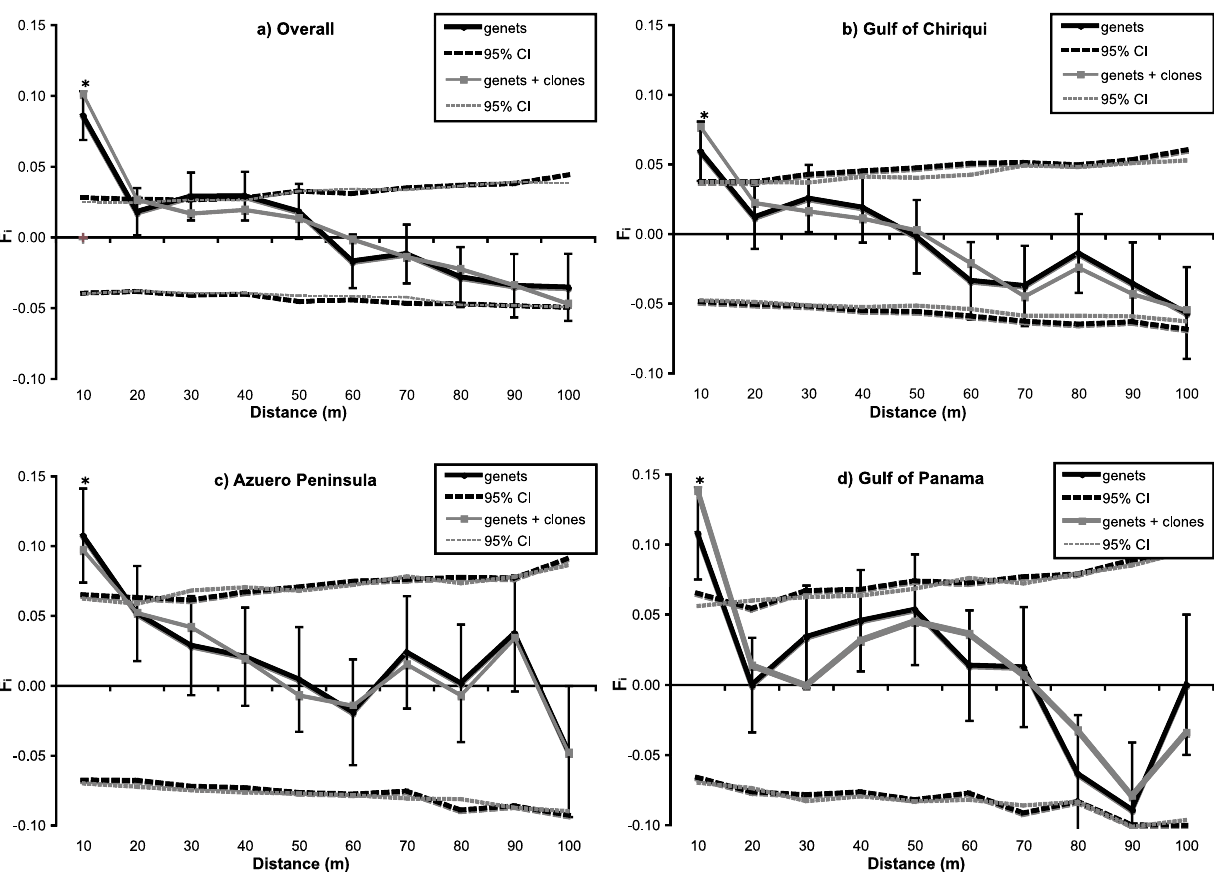
Figure 3. Spatial correlograms of the SpaGeDi [ 145 ] analysis of Spatial Genetic Structure (SGS) among specimen within discrete distance classes. Black lines represent the genet dataset, excluding clones and grey lines show the results for the ramet dataset, including clones. Dashed lines are the permuted 95% confidence intervals. Error bars are 95% bootstrap errors of the genet datasets. Figure 3a ) Spatial correlogram of the average pairwise kinship F ij [146] as a function of distance over all populations. Figure 3b – d ) Spatial correlograms over the populations in each of the three regions, b) the Gulf of Chiriqui, c) the Azuero Peninsula and d) the Gulf of Panama.